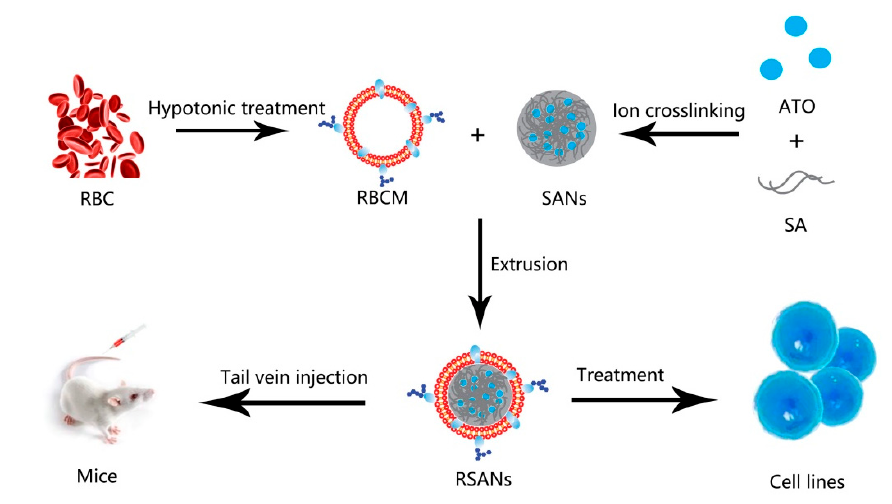
Figure 1. Preparation and Characterization of RSANs.